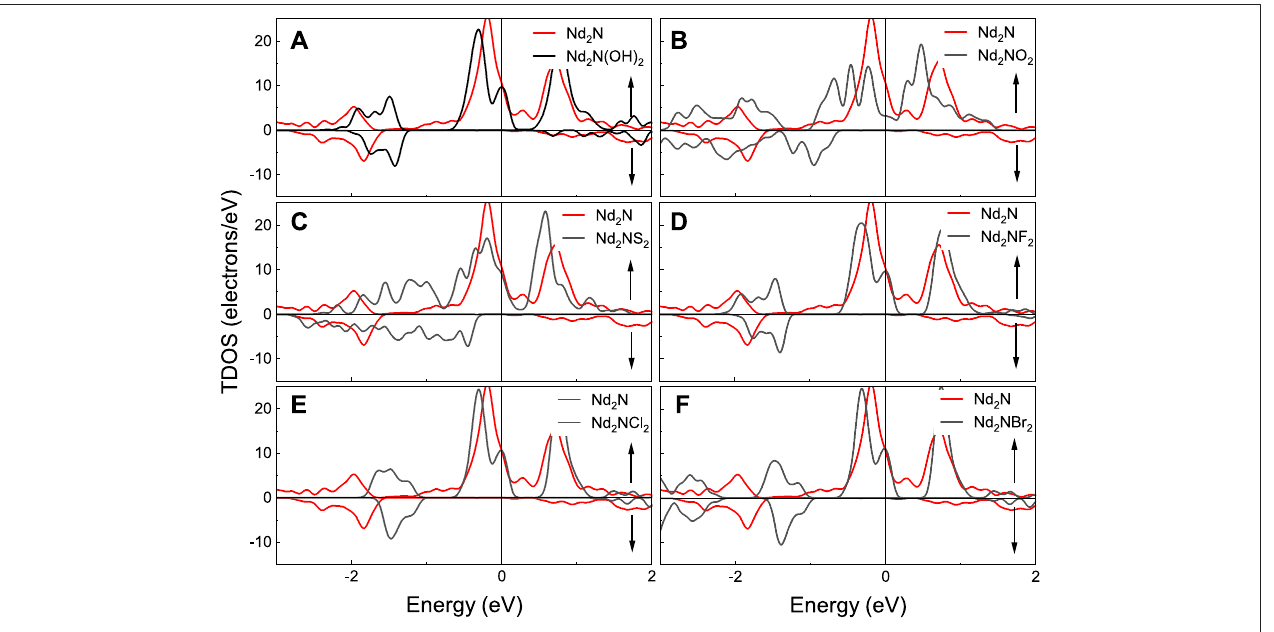
FIGURE 4 | Total density of states (TDOS) of Nd 2 N and Nd 2 NT 2 (T = OH, O, S, F, Cl, and Br). The red line represents Nd 2 N, whereas the black line denotes is (A)